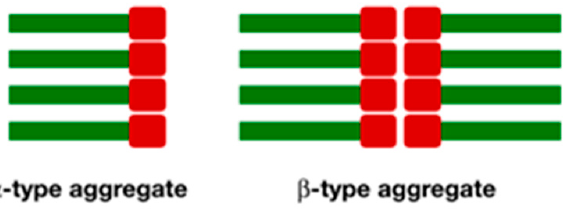
Figure 11. Cartoon representing the spatial disposition of monomers in α - and β -aggregates [38]. Red: polar heads; green: hydrophobic chains.